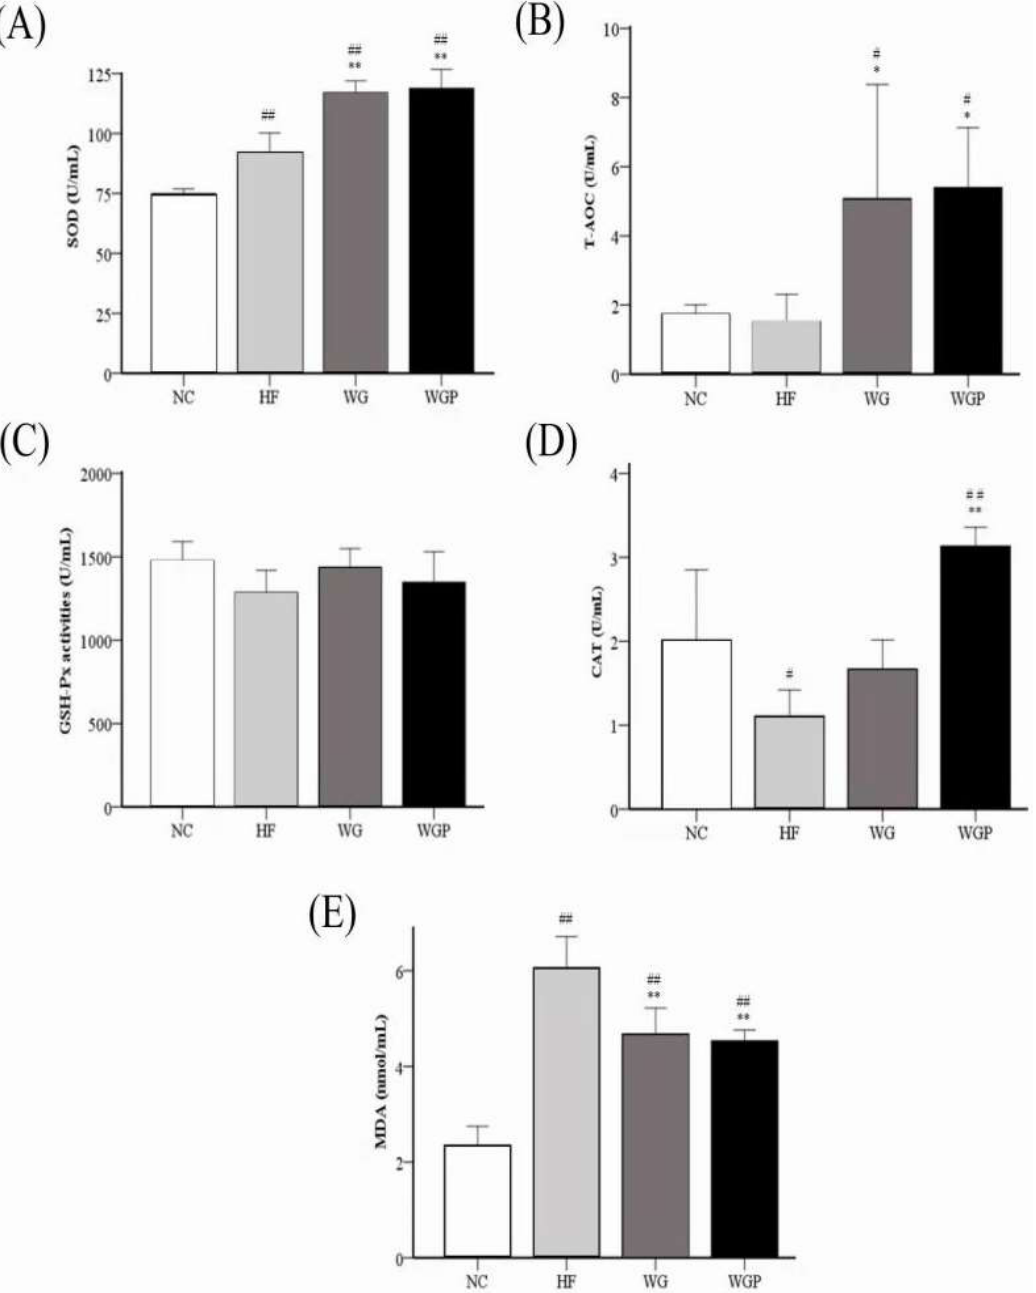
Figure 6. Effect of wheat germ and wheat germ protein on serum antioxidant status, SOD ( A ), T- AOC ( B ), GSH-Px ( C ), CAT ( D ) and MDA ( E ), in the high-fat diet-induced rats. Values are presented as means ± SEMs ( n = 5). # p < 0.05, ## p < 0.01 vs. NC group. * p < 0.05, ** p < 0.01 vs. HF group.